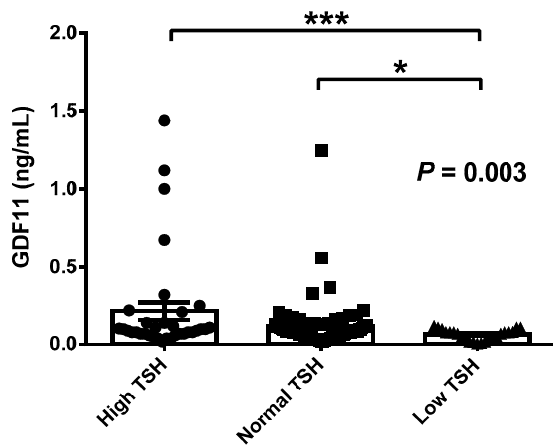
Figure 2. Serum GDF11 concentrations in subjects with high ( n = 32), normal ( n = 76), and low ( n = 20) concentrations of TSH. Bars represent mean ± SEM. Statistical differences between groups were analyzed by one-way ANOVA followed by Fisher’s least significant difference (LSD) tests. * p < 0.05 and *** p < 0.001. GDF11 concentrations were logarithmically transformed for statistical analysis due to their non-normal distribution. Table 4. Demographic, biochemical, and metabolic characteristics of the individuals classified according to TSH circulating concentrations.